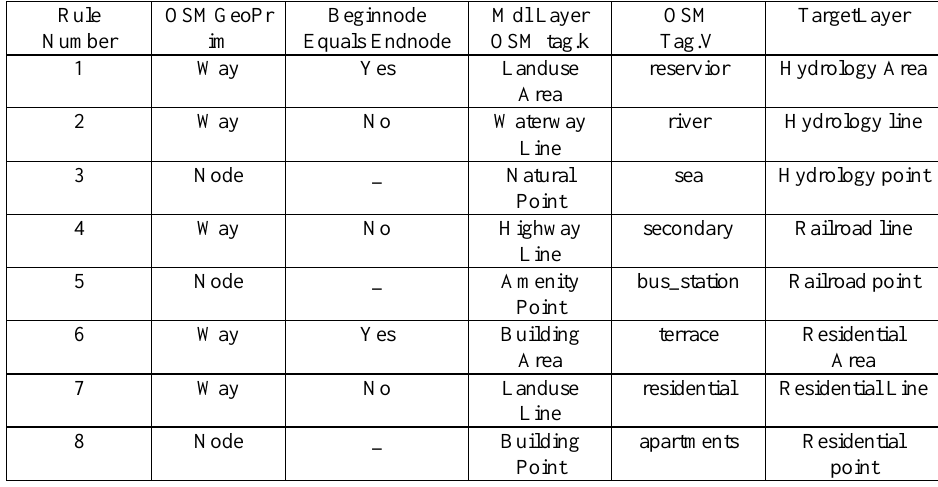
Table 1 Examples rules for converting the middle data model to user destination